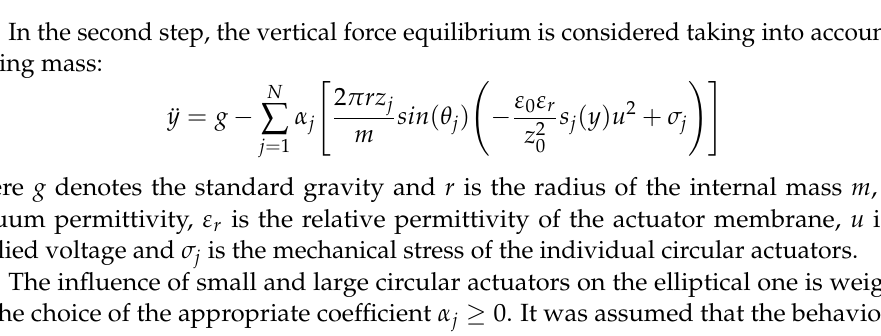
Figure 2. The variables of DEAP actuator for cross-section through short/long axes of the elliptical